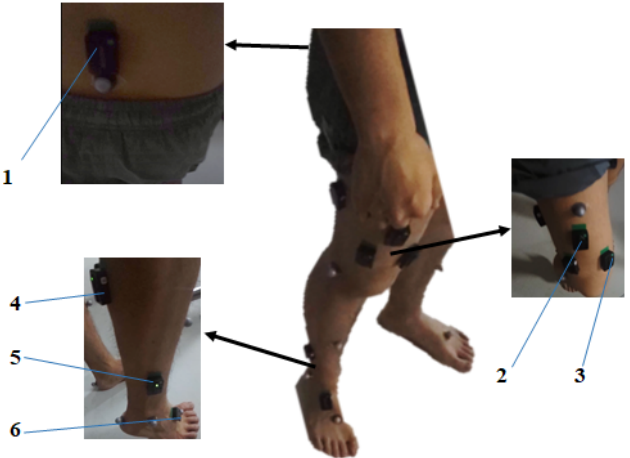
Figure 4. The sensor attachment on subjects. The numbers 1–6 denote the IMUs placed on the lower back, the thigh, the shank and the foot, repspectively.